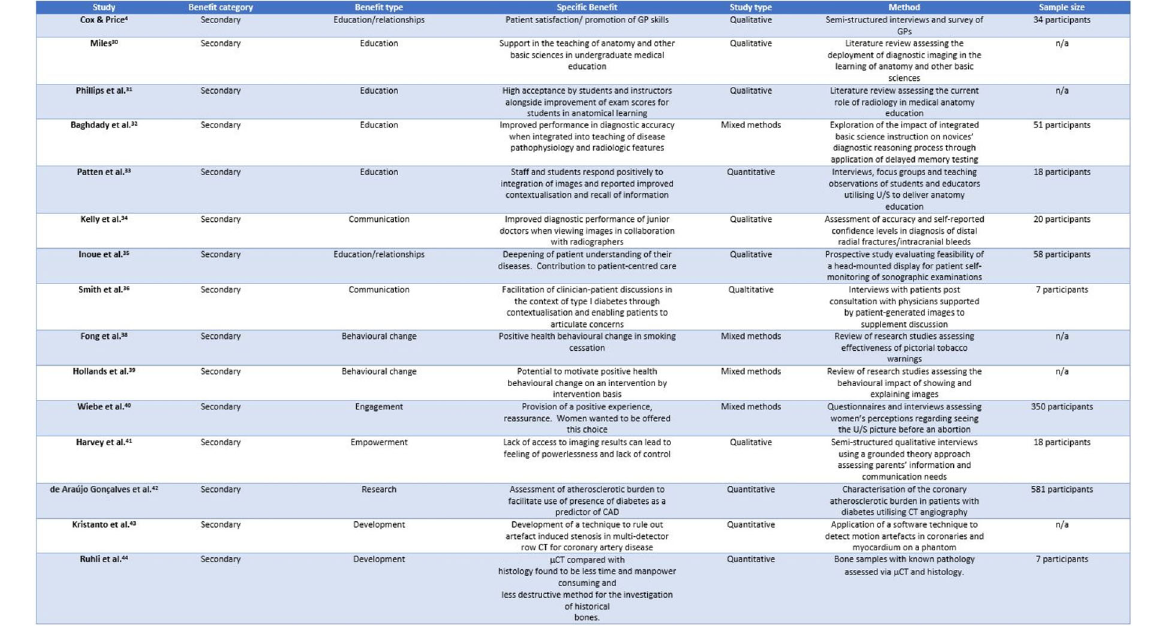
Cox et al. Insights into